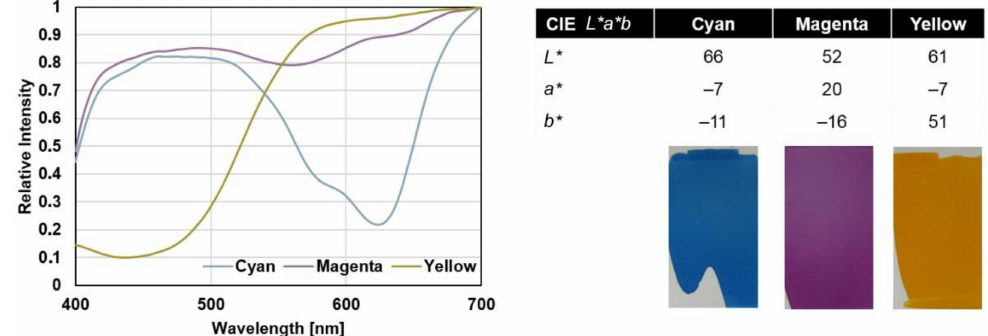
Figure 5. Transmission spectra, CIE L * a * b * values from the reflection UV-VIS spectra and photographs of the visible light (VIS) trigger-able photochromic colorant systems. Solvent-based ink formulations were used. The prints were prepared on plastic STYRENE sheets by doctor blading (12 µ m) and drying at ambient